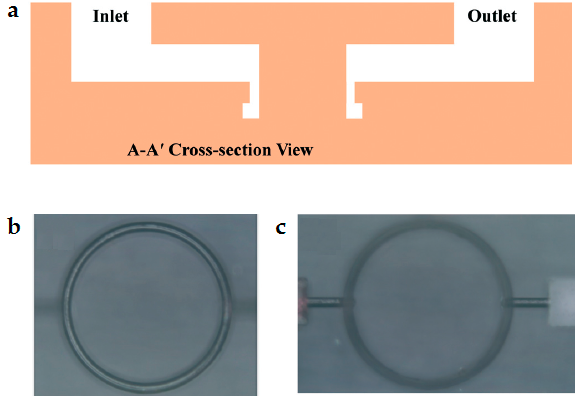
Figure 6. ( a ) Cross-sectional view of the monolithic optofluidic ring resonator; ( b , c ) Micrographs of the bottom and the top by focusing on the ring and the fluid delivery channel, respectively [2].